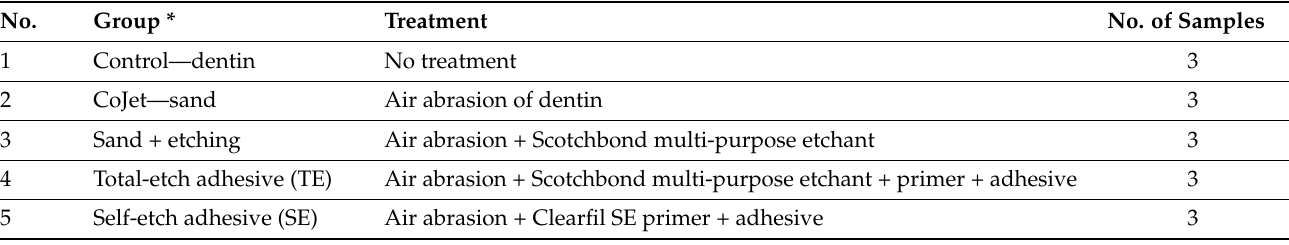
Table 3. Description of study groups analyzed by SEM and